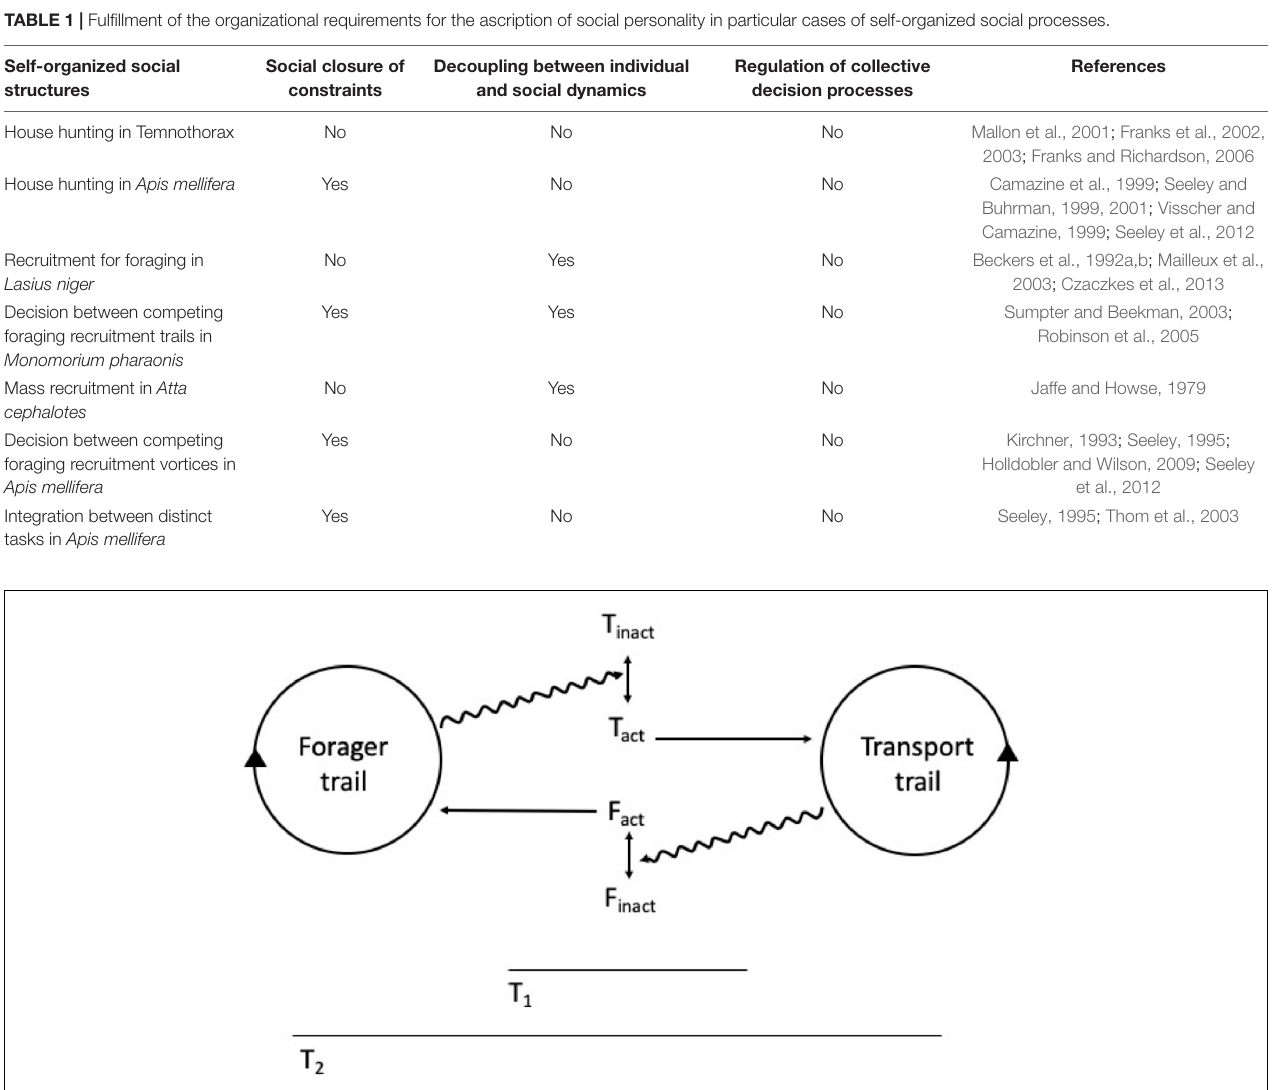
FIGURE 2 | Forager and transporter trails (socially self-organized systems—SSSs) constrain information flow, thus causing individuals to change their internal state, between inactivity (inact) and activity (act). As a result, both SSSs act indirectly upon each other through recruitment processes. Both transporters (T) and foragers (F) are depicted; T1 and T2 are different time